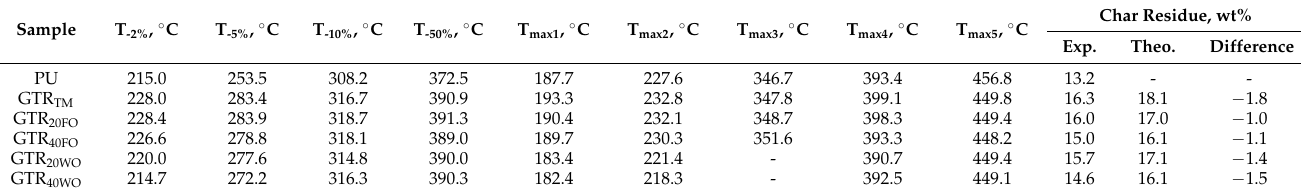
Table 7. The results of thermogravimetric analysis of polyurethane/GTR composite